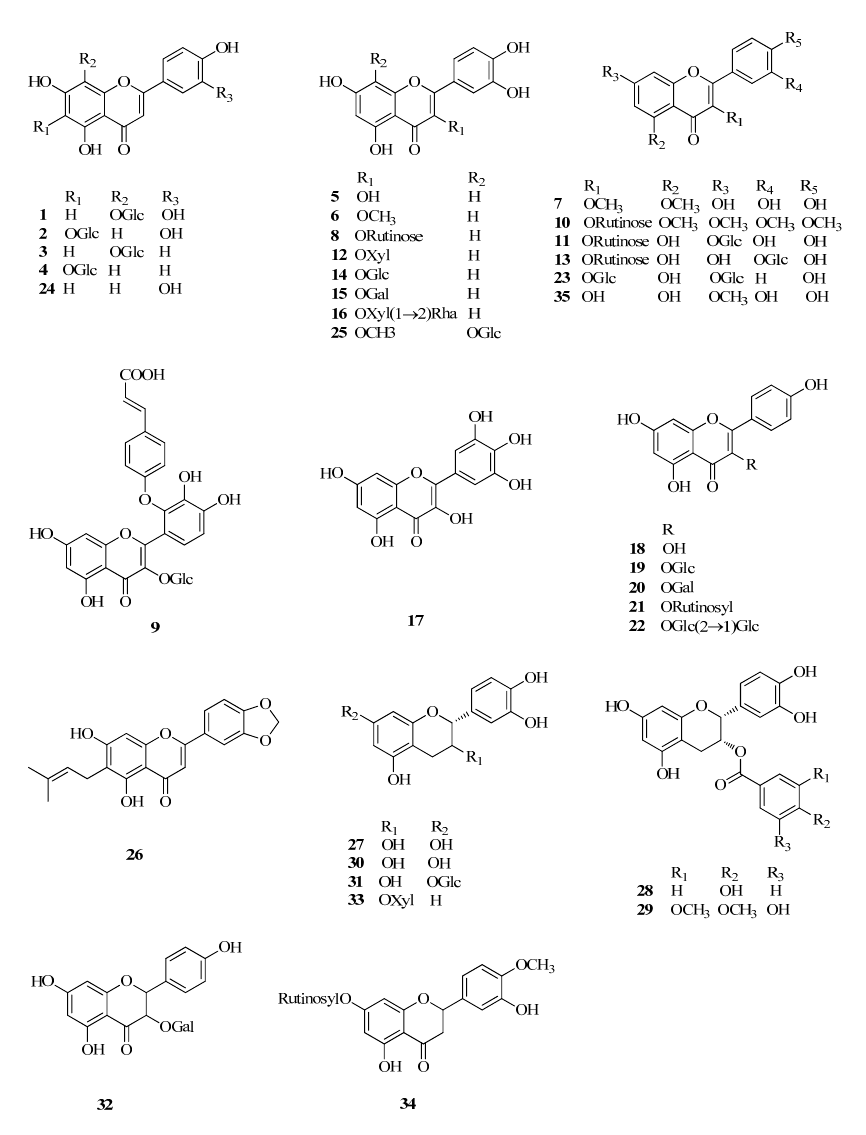
Figure 2. Structures of tannin compounds isolated from F. esculentum , F. tataricum and F. diabotrys .